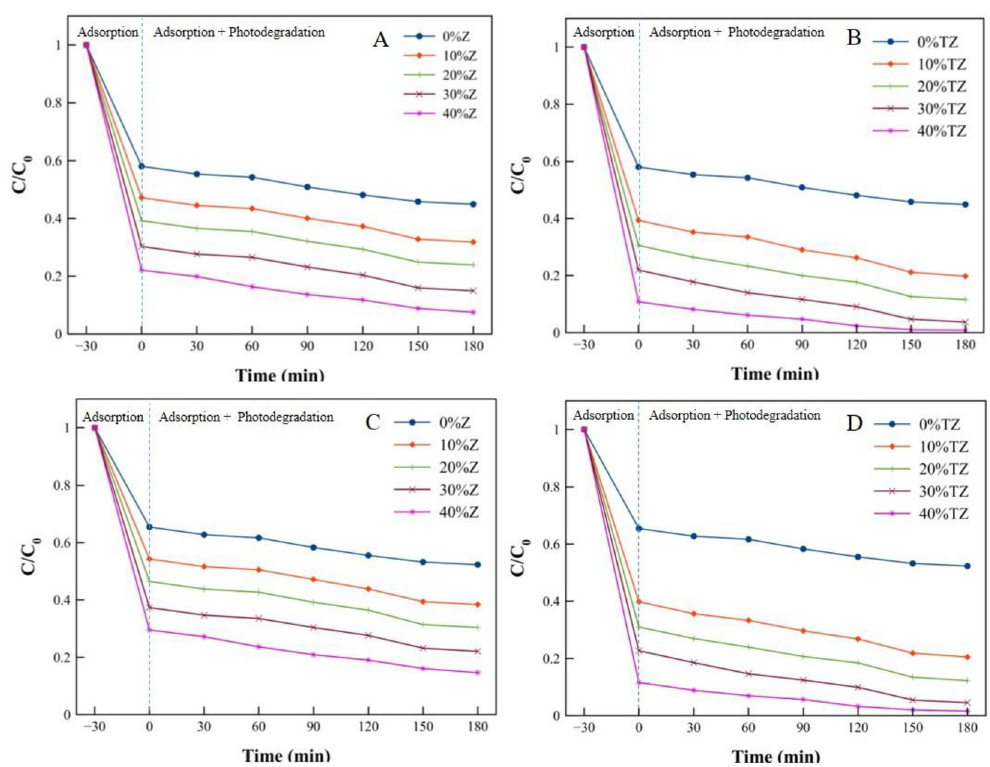
Fig 10. MB adsorption and photocatalytic degradation (at 40 mg/L) of powdered geopolymer composites containing different amounts of zeolite and TiO 2 /zeolite (A) Fresh geopolymer composite containing zeolite, (B) fresh geopolymer composite containing TiO 2 /zeolite, (C) reused geopolymer composite containing zeolite and (D) reused geopolymer composite containing TiO 2 /zeolite.